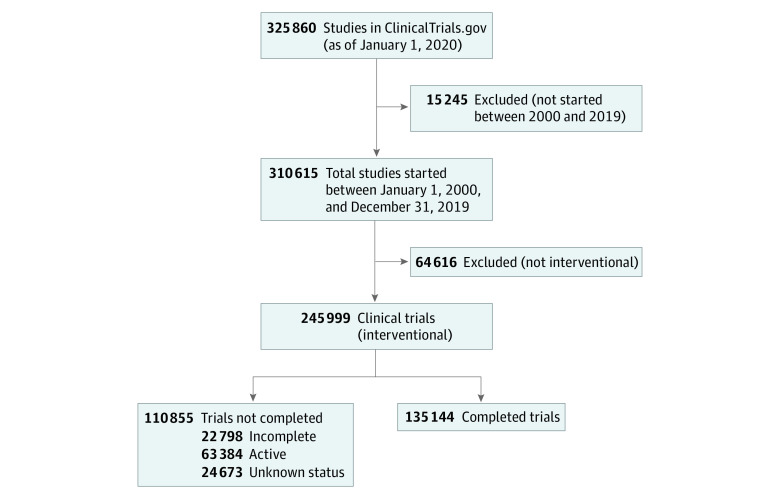
Flow DiagramIncomplete indicates terminated, suspended, or withdrawn, and active indicates recruiting, not yet recruiting, active, or enrolling by invitation.